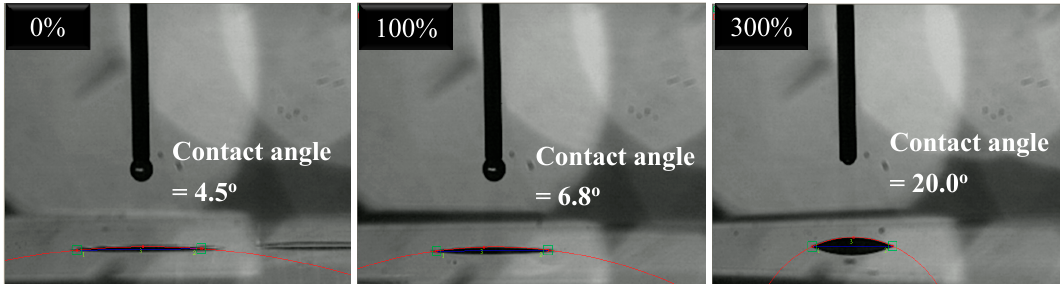
Figure 12. Measurements of contact angle on various C–TiO 2 surfaces obtained in glucose solutions of different concentrations.